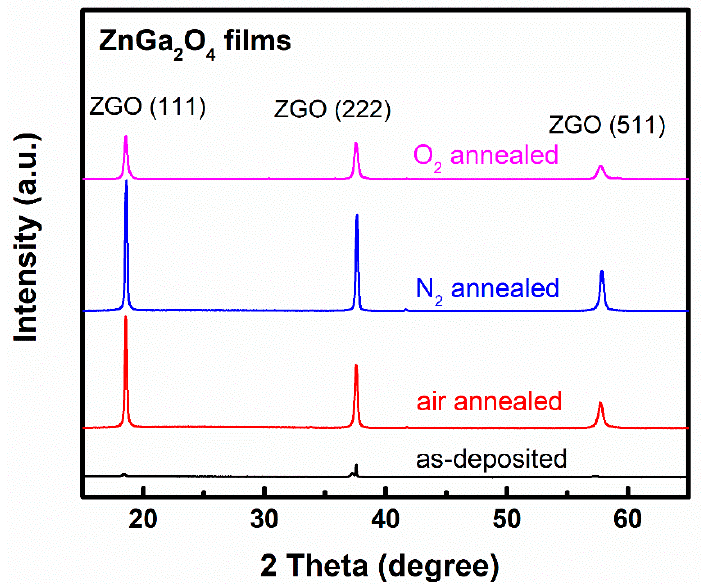
Figure 1. X-ray diffraction patterns of ZnGa 2 O 4 (ZGO) films under different annealing ambiences.